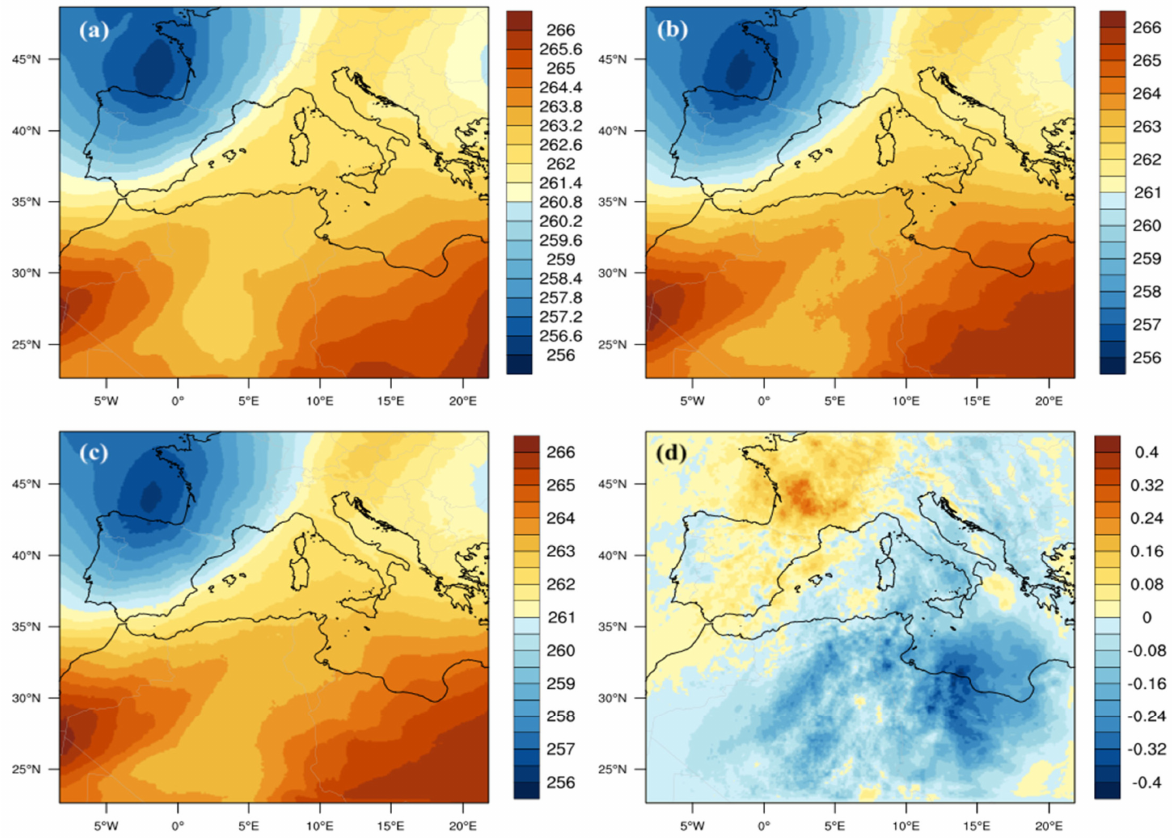
Figure A2. Averaged (17–24 June) temperature at 500 hPa by ( a ) ERA5; ( b ) CTL; ( c ) FULL; ( d ) FULL − CTL. Units are K.